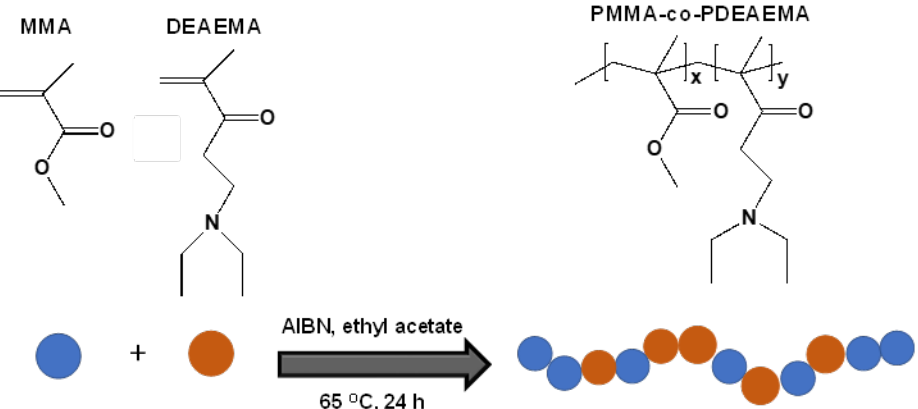
Figure 3. Synthetic procedure followed for the preparation of the PMMA x - co -PDEAEMA y random copolymer by free radical polymerization and chemical structures of the MMA and DEAEMA monomeric units.